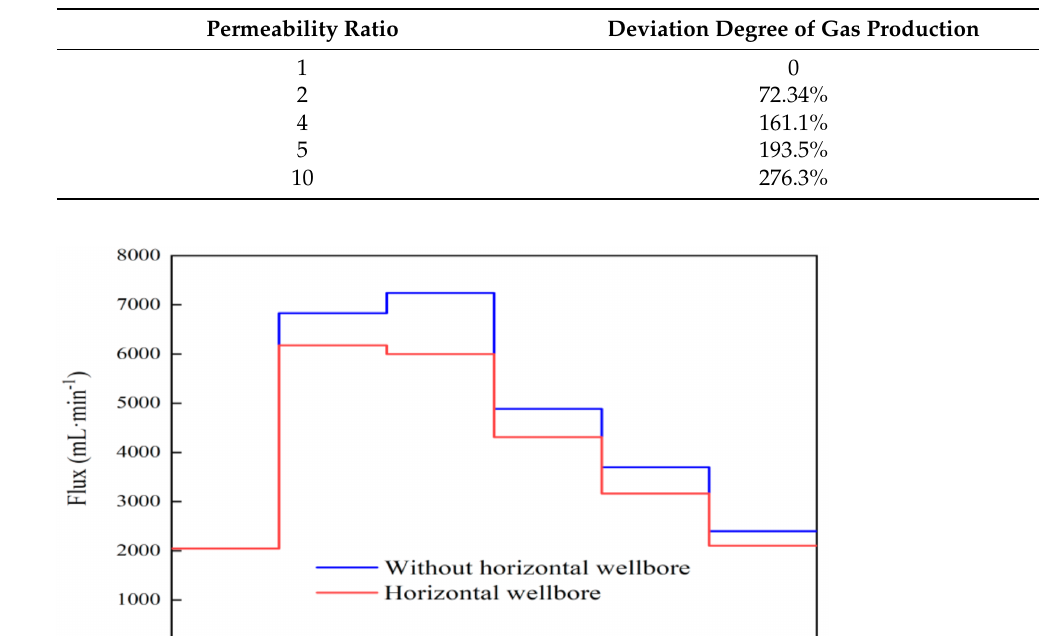
Figure 2. Gas production profile of cores with different permeabilities in parallel with a positive se- quence. Table 4. Statistical table of the corresponding relationship between permeability ratio and deviation degree of gas production ( δ ).